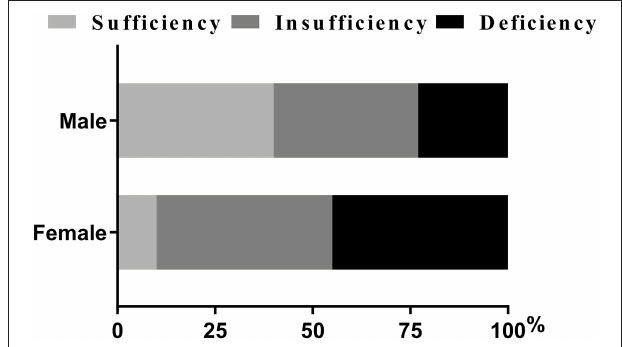
FIGURE 2 | Percentage of patients with vitamin D status (%). Chi-squared tests and post hoc Bonferroni corrections for multiple comparisons were used for comparison between genders. Our data showed there were statistical differences in insufficiency and deficiency groups when categorized by genders.